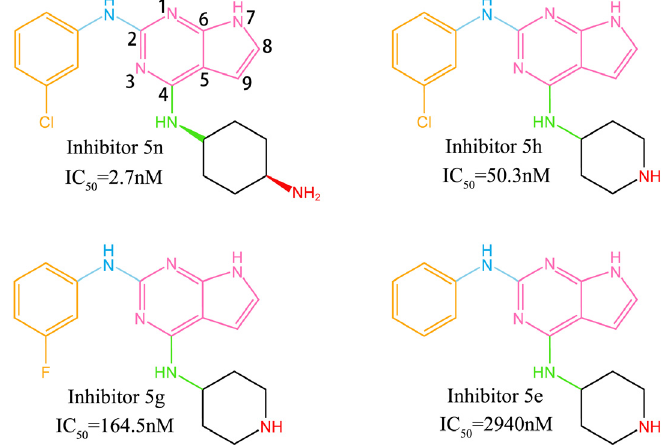
Figure 2. The 2D structures of four pyrrolo [2,3-d] pyrimidine inhibitors. The atomic number of the parent nucleus is marked on the inhibitor 5n. The different colors represent the different parts of the inhibitors. The pink group is the pyrrolo [2,3-d] pyrimidine parent nucleus; the orange group is called the 2-benzene ring; the blue group is called the 2-imino; the green group is called the 4-imino; and the black group is called the 4-hexatomic ring. The red group is called the terminal amino group (inhibitor 5n) or the terminal imino group (inhibitor 5h, 5g, and 5e).